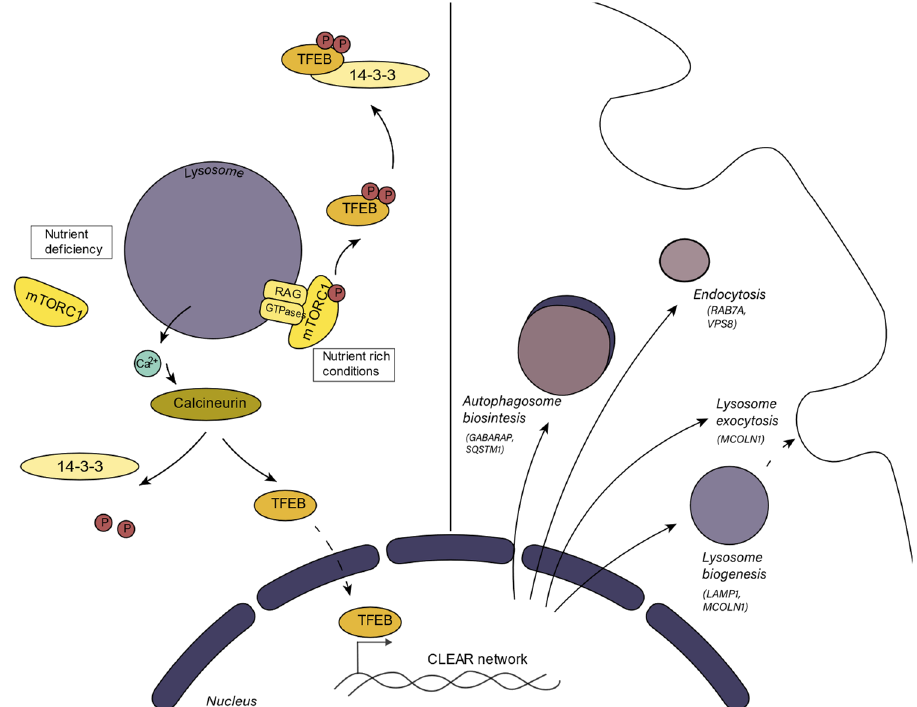
Figure 1. An overview of TFEB regulation through mTORC1 and calcineurin activity. Under nutrient rich conditions, mTORC1 phosphorylates TFEB, which is sequestered in the cytosol by 14-3-3 proteins. Under nutrient deficiency, mTORC1 is inactive, and calcineurin eliminates TFEB phosphates, allowing nuclear translocation, where TFEB induces the expression of genes related to autophagy, endocytosis, lysosome exocytosis, and lysosome biogenesis.